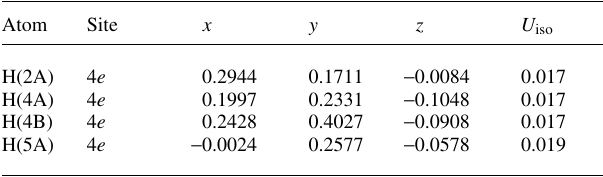
Table 2. Atomic coordinates and displacement parameters (in Å 2 ) .